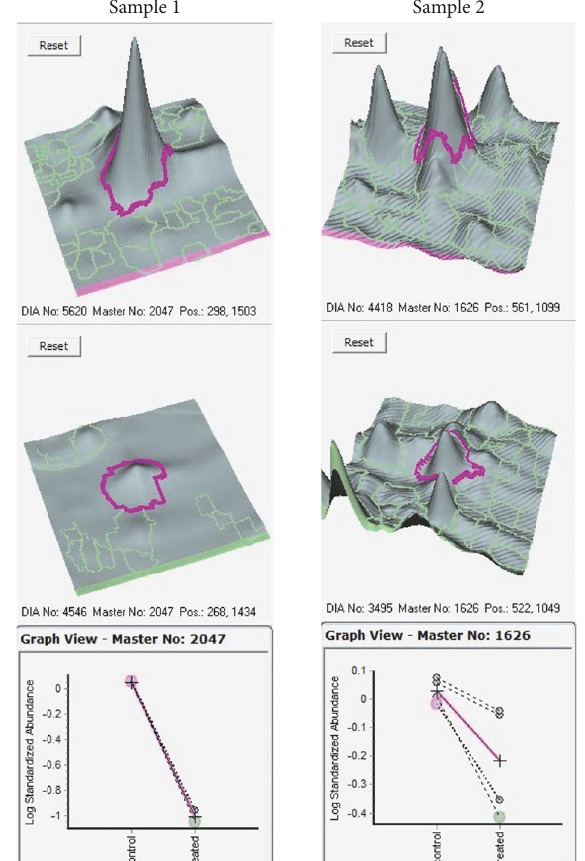
Figure 1: (a) 2D-DIGE gel. Protein spots labelled Cy2 (yellow std), Cy3 (red), and Cy5 (blue) from gel nro 3. Isoelectric focusing (pH 4–7, linear) is shown on top of the figure; MW is shown on the left vertical axis. (b) Silver-stained 2D-DIGE gel. Protein spots cut out of the gel are enumerated and encircled. Corresponding spots are found from (a).